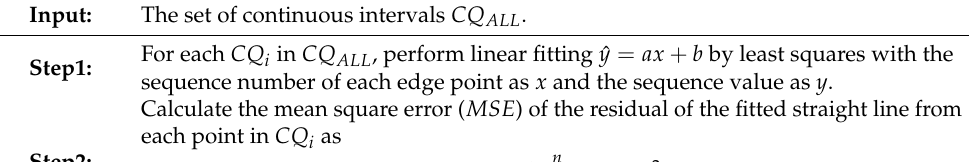
Table 4. Steps of the Linearity Processing.